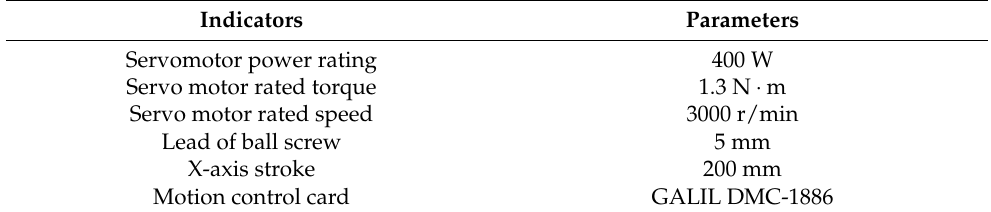
Figure 6. Block diagram of the control system. Table 4. Parameters of experimental platform.